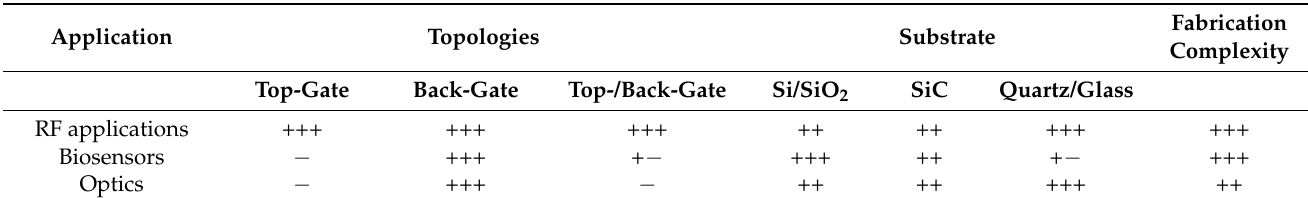
Fabrication Complexity